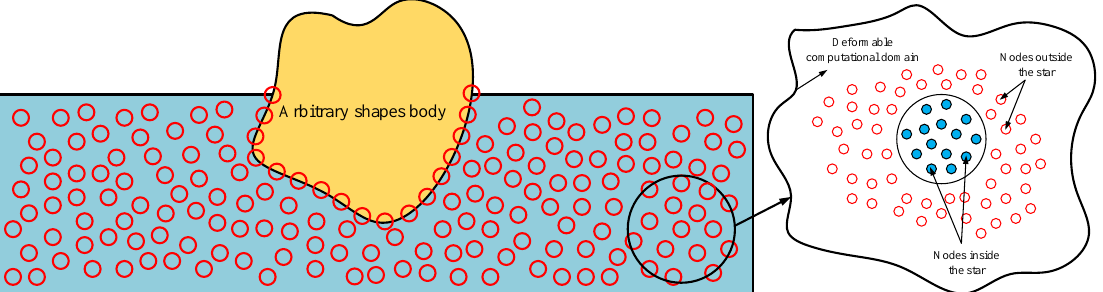
Figure 3. Distribution of computational nodes within the NWF and the schematic diagram of star in the generalized finite difference method